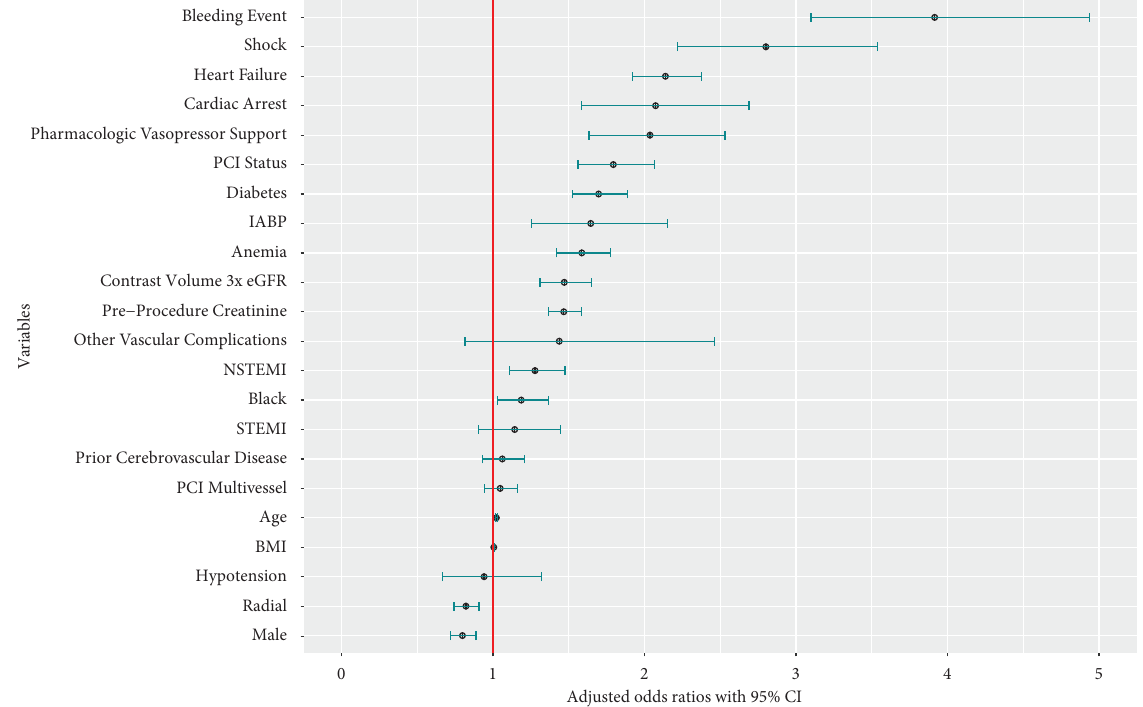
Figure 2: Odds ratio from logistic regression on AKI after PCI with propensity score weights. Abbreviations: AKI � acute kidney injury; BMI � body mass index; CI � 95% confdence interval; eGFR � estimated glomerular fltration rate; IABP � intra-aortic balloon pump; NSTEMI � non-ST-segment elevation myocardial infarction; PCI � percutaneous coronary intervention; STEMI � ST-segment elevation myocardial infarction.